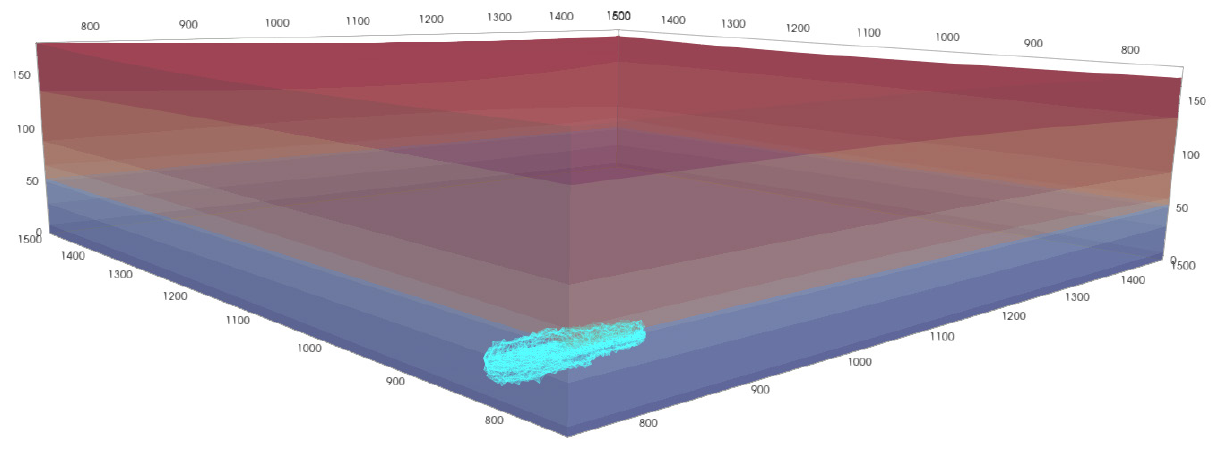
Figure 8 : Spatial situation of area of water vapour presence at time t = 1